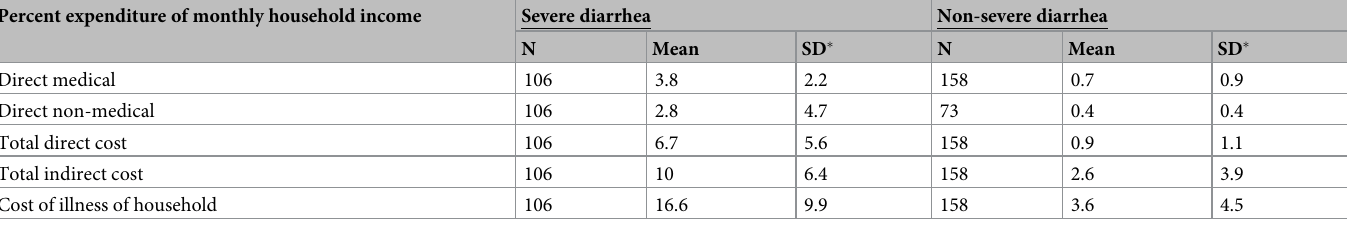
Table 3. Percent expenditure of monthly household income for severe and non-severe diarrhea of Tongi Township in Dhaka, Bangladesh from September 2015 to June 2016. Percent expenditure of monthly household